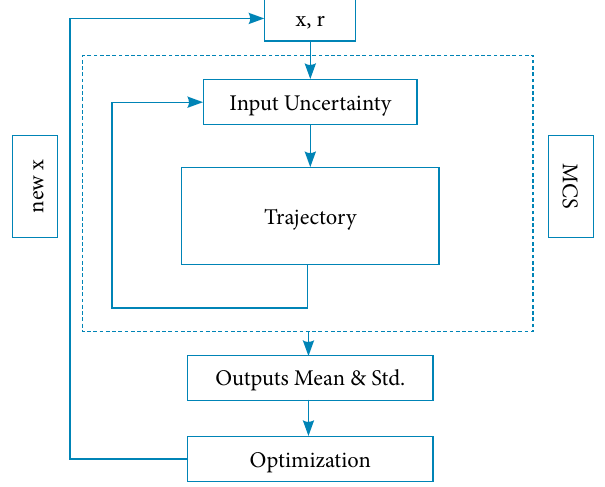
Figure 5. Robust design optimization process.